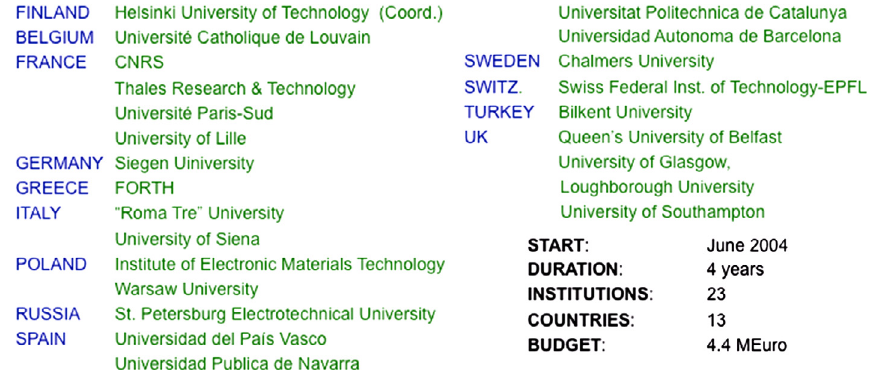
Figure 1. List of the partners and key-facts of the FP-6 Network of Excellence METAMORPHOSE